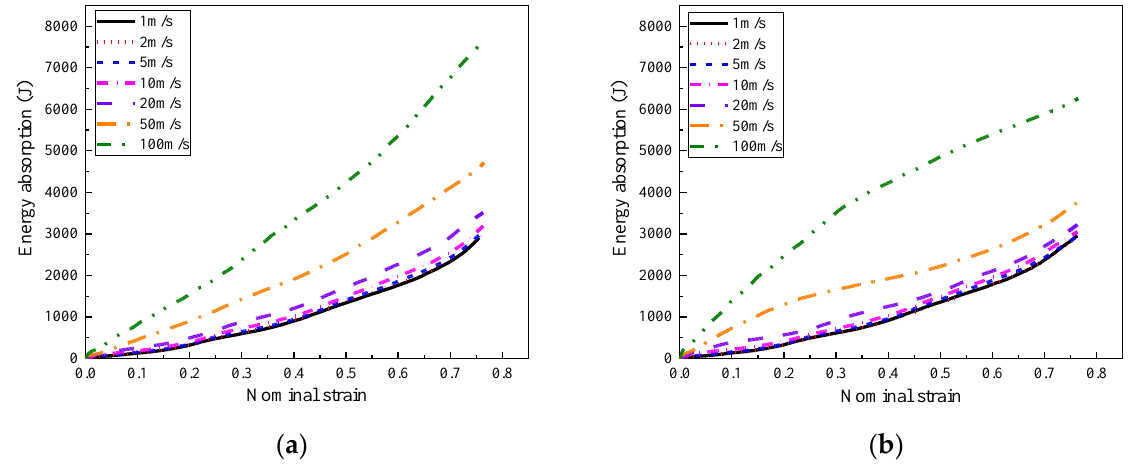
Figure 27. The energy absorption of the composite ( t = 0.4:0.4:0.4) with different foam concrete density gradient directions: ( a ) positive gradient ( ρ = 408:575:848); ( b ) negative gradient ( ρ = 848:575:408).